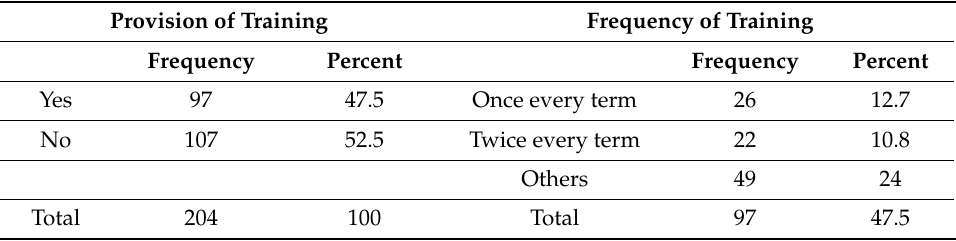
Table 2. Food handler training on healthy food preparation, food safety, and sanitation.